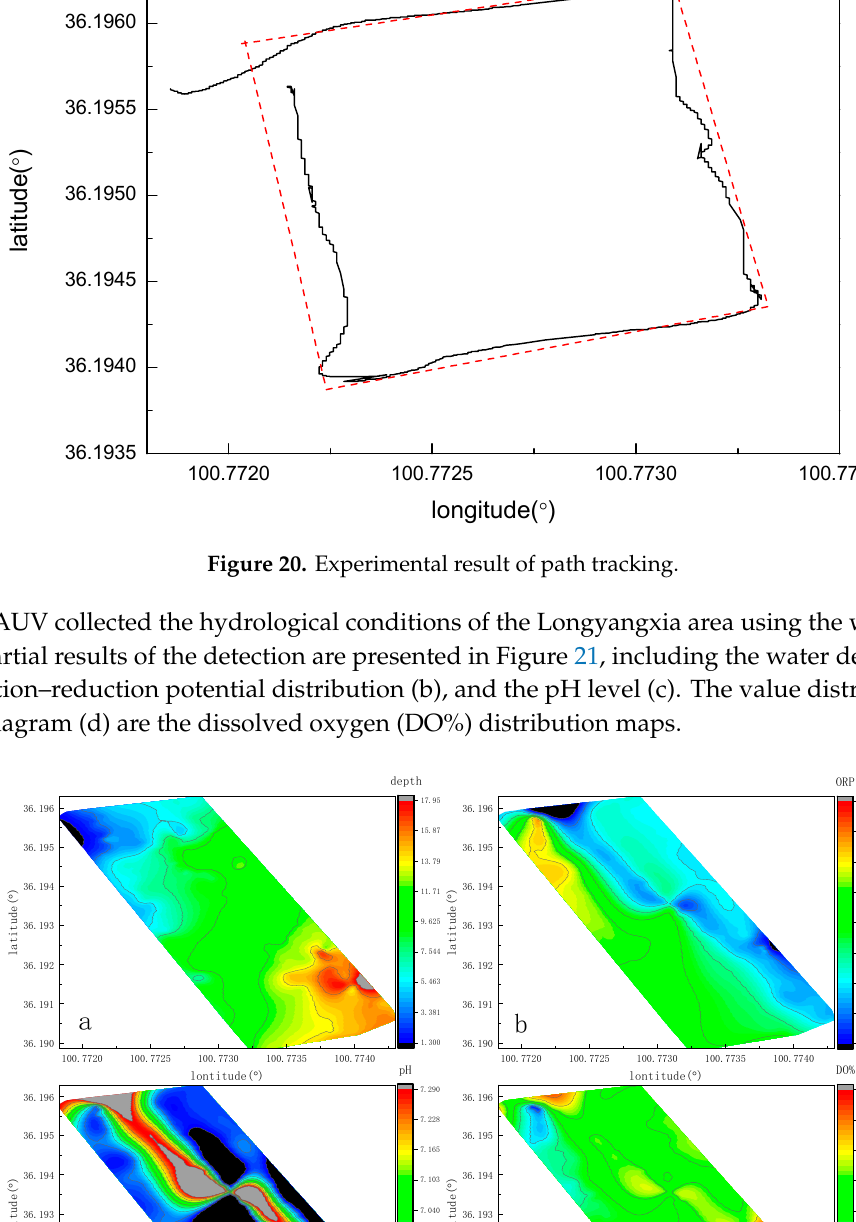
Figure 19. Experimental result of automatic control.